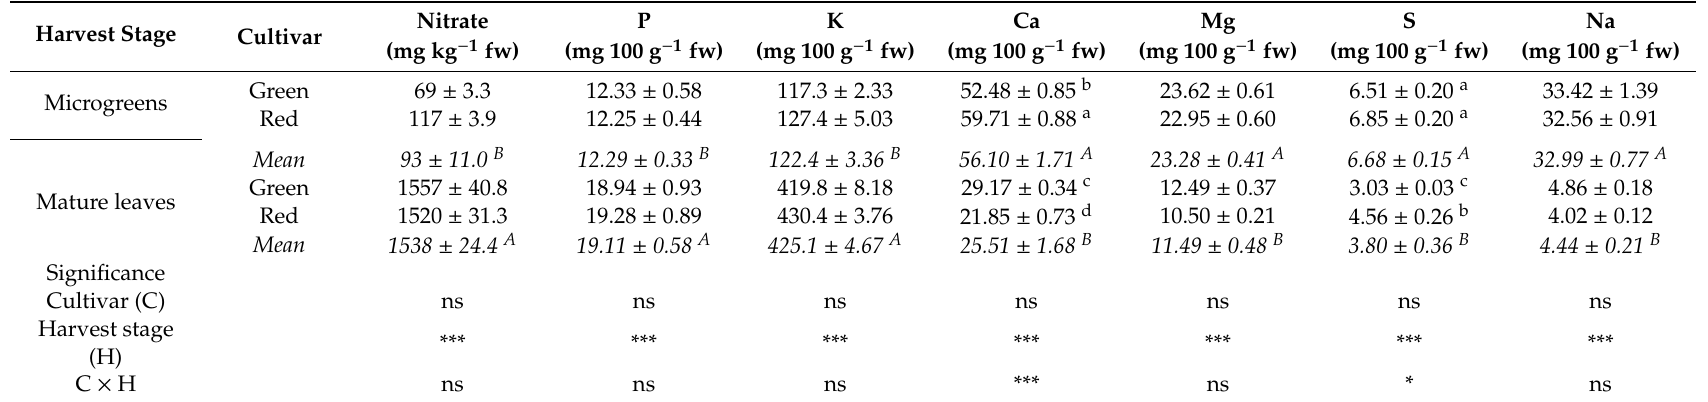
Table 1. Nitrate concentration and macronutrient content of green and red Salanova butterhead lettuce as influenced by harvest